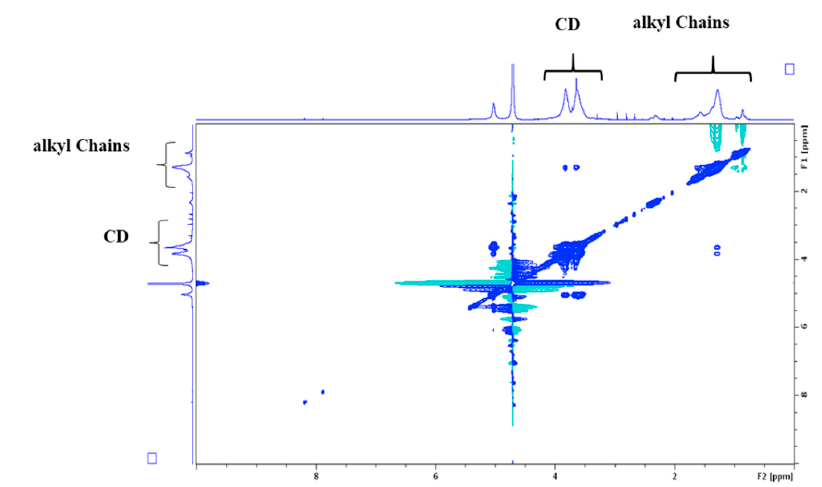
Figure 5. Partial contour plot of a T-ROESY experiment (spin lock: 300 ms, 22 dB) performed at 600 MHz on 1 at 12 mM in D 2 O.